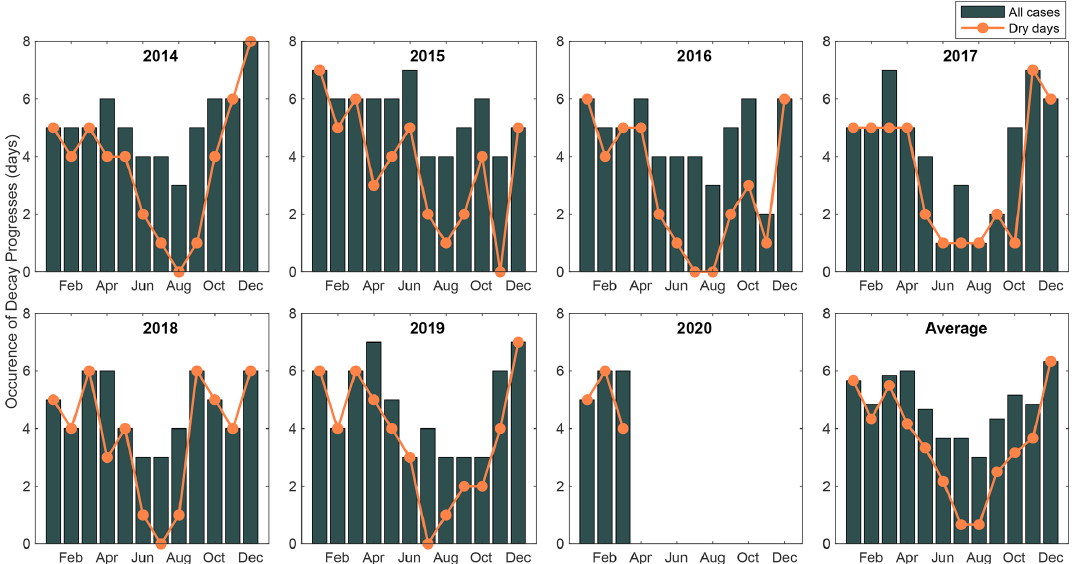
Figure 4. Monthly cumulative occurrence of the decay processes of pollution episodes. The orange curve indicates the decay process oc- currences on dry days. In total, 365 decay processes are identified from January 2014 to March 2020, and 97 of them are associated with precipitation levels greater than 10mmd − 1